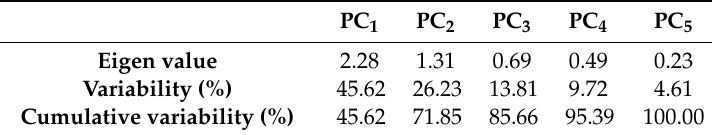
Table A1. Eigenvalues obtained from PCA.